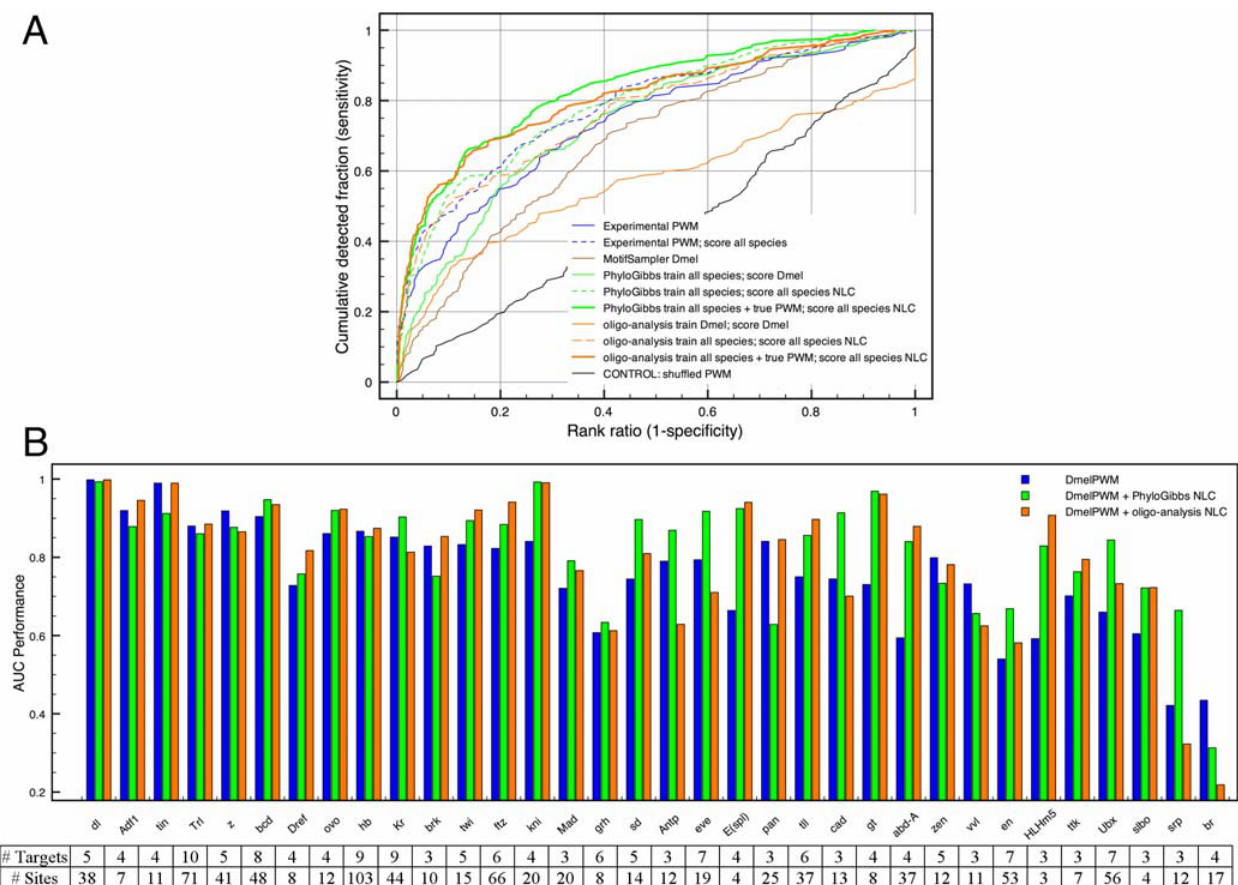
Figure 5. LOOCV performances for heterotypic CRM-models. (A) Heterotypic models consist of PWMs obtained by motif discovery on Dmel sequences using MotifSampler (brown curve) or oligo-analysis (orange curve) and on all species using PhyloGibbs (green curve). Models consisting of combined de novo PWMs with the true experimental PWM are shown for oligo-analysis (dashed orange) and PhyloGibbs (dashed green). Scoring is either done on Dmel alone (thin full lines) or on all species by network-level conservation (NLC) (thick lines and dashed lines). (B) In green and orange are LOOCV performances for scoring with heterotypic models (either species-specific for oligo-analysis or cross-species for PhyloGibbs) on all species including the Dmel PWM (cfr thick full lines in A). Scoring on all species is done by network-level conservation (NLC). In blue is the control, namely NLC using the Dmel PWM alone, without newly discovered motifs.